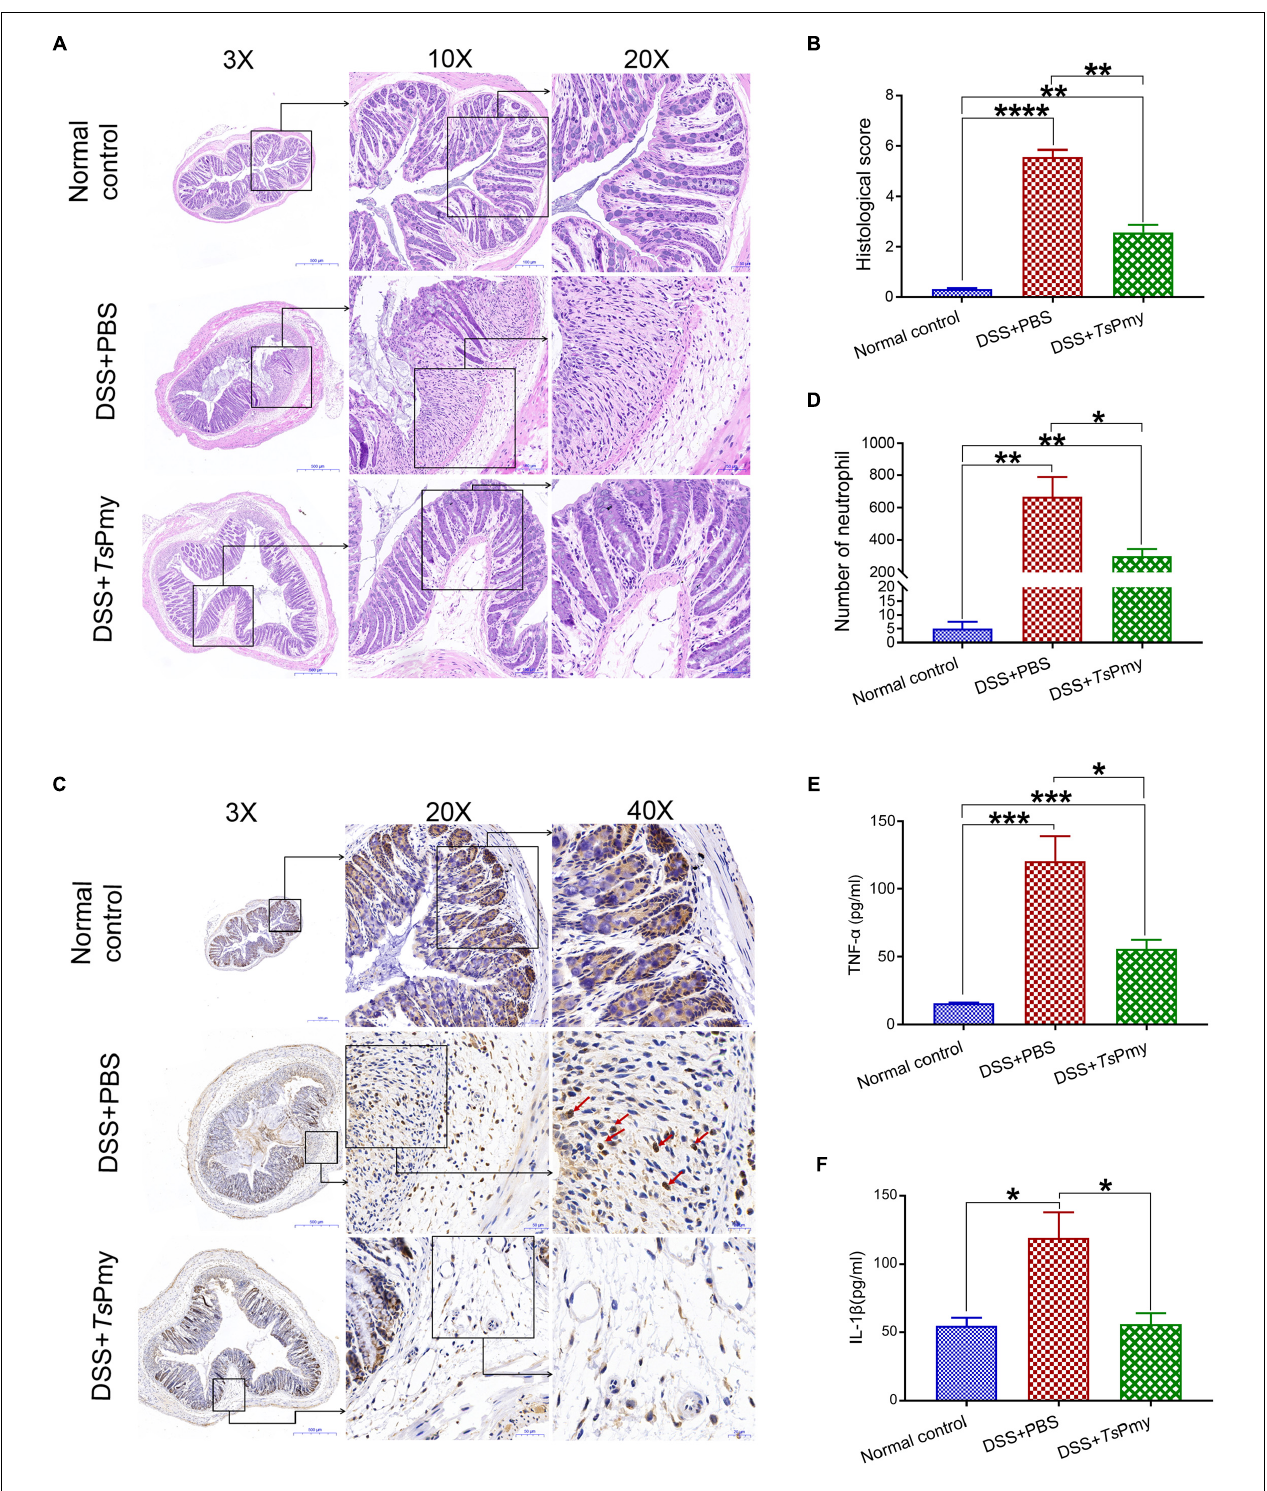
FIGURE 2 | Treatment with r Ts Pmy improves the histopathological changes of DSS-induced acute colitis. (A) The representative histopathological sections of distal colon at objective 3x, 10x, and 20x. (B) The histological scores of colon in each group ( n = 5). (C) Immunohistochemical (IHC) staining of myeloperoxidase (MPO) reflecting neutrophil infiltration (red arrows) in the distal colon. (D) The number of neutrophils of whole cross-section of distal colon in each group ( n = 5). (E) The level of cytokines TNF- α derived by colonic epithelial layers cells ( n = 5). (F) The level of cytokines IL-1 β of colon homogenate ( n = 5). The data represent the mean ± SEM. * p < 0.05, ** p < 0.01, *** p < 0.001, **** p < 0.0001.